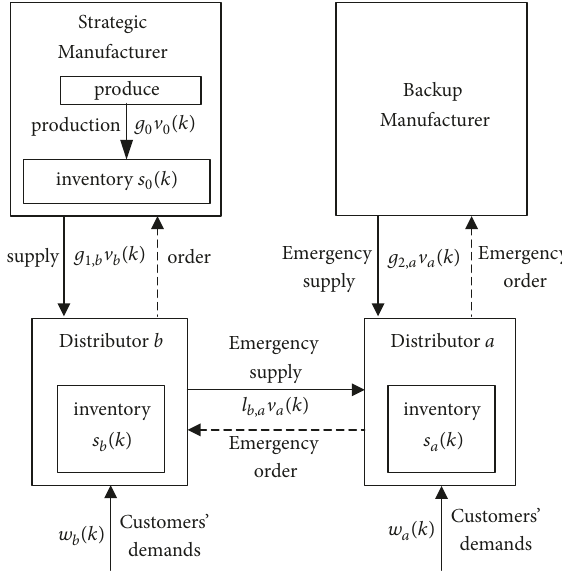
Figure 1: Emergency supply chain